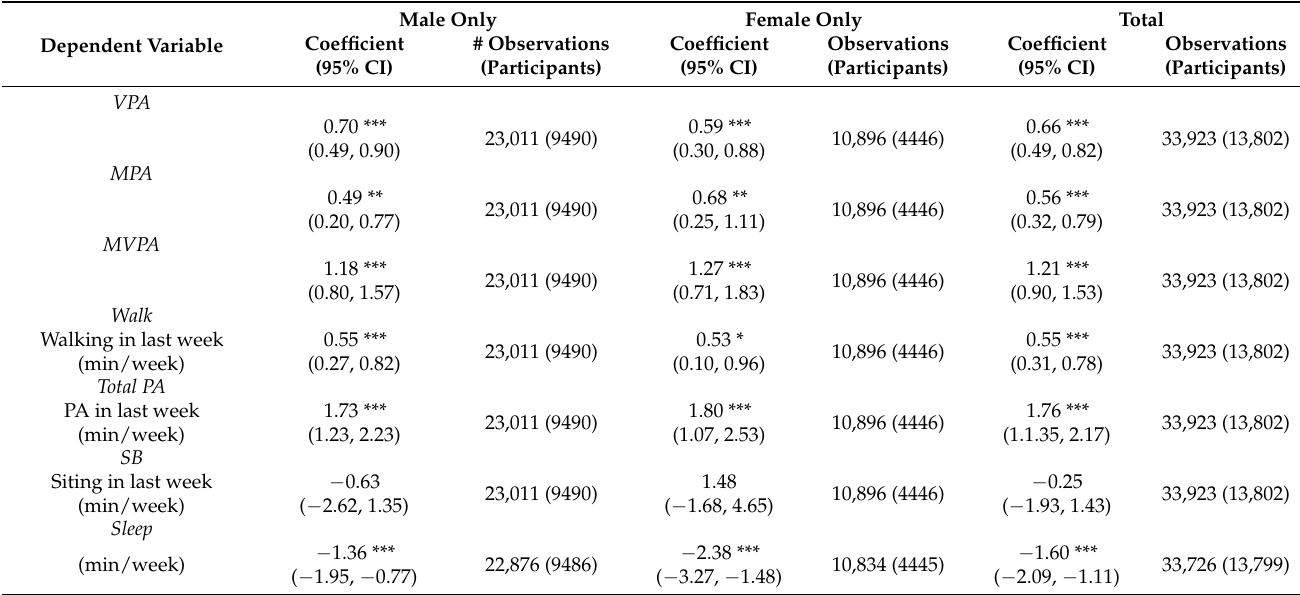
Table 3. Estimated effects of temperature on individual-level sleeping outcomes in the past week per day by